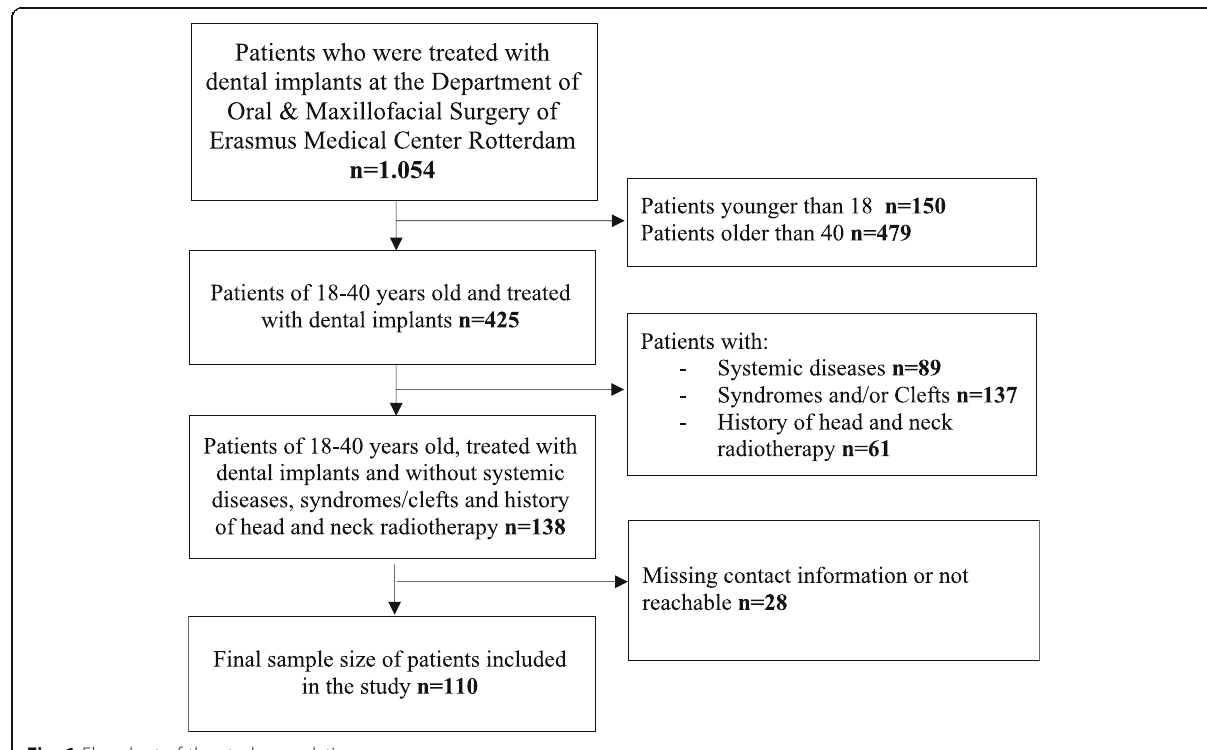
Fig. 1 Flowchart of the study